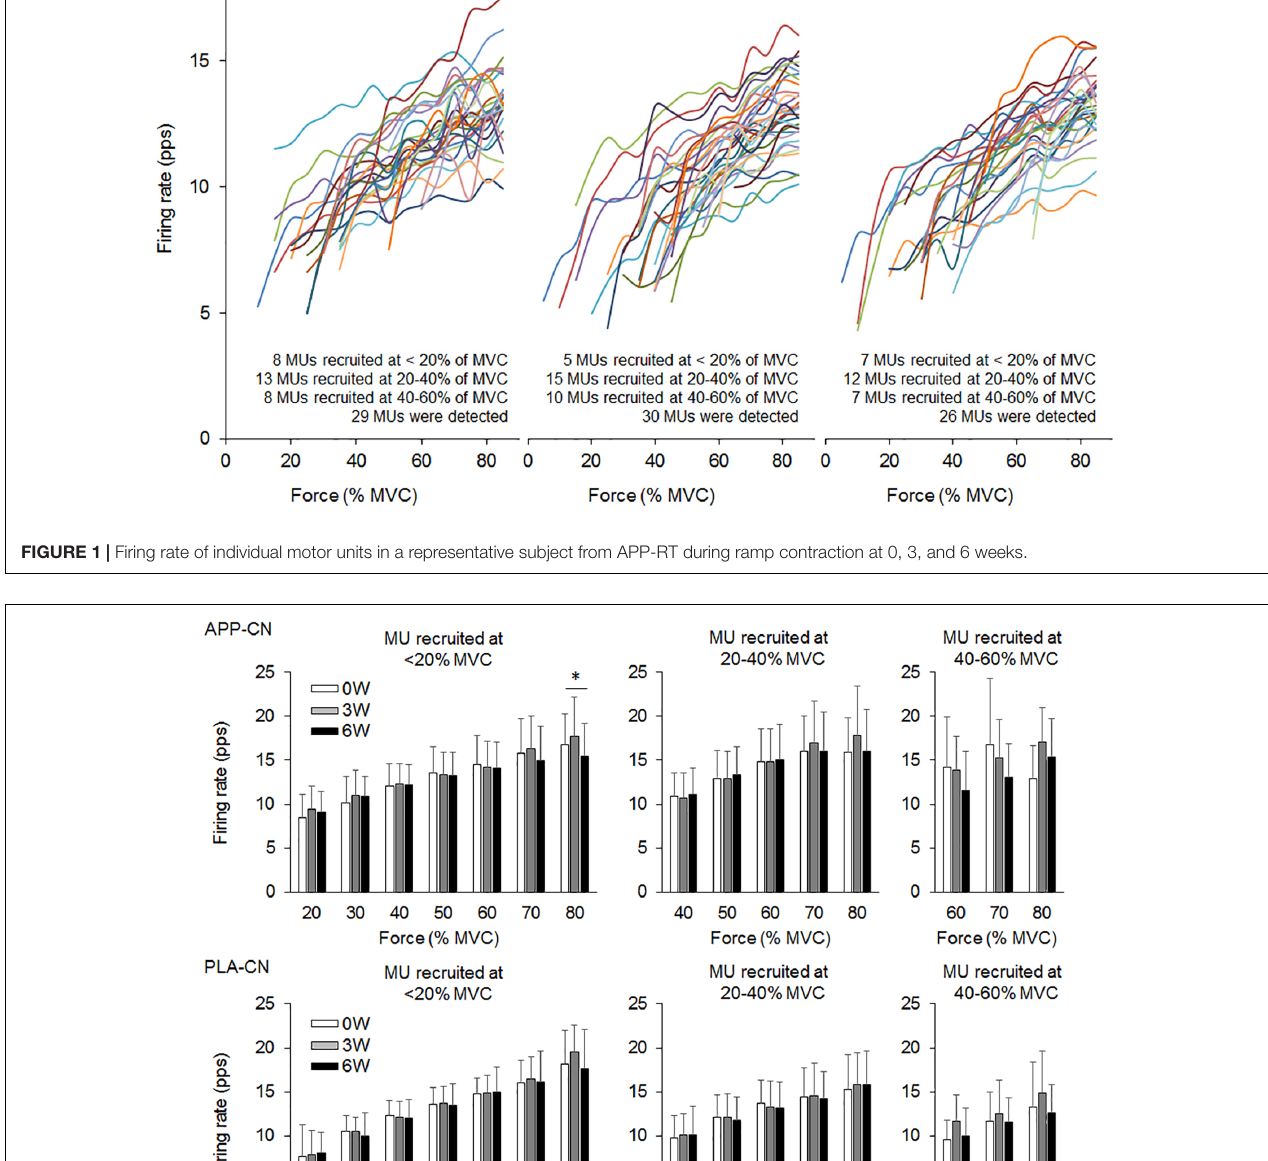
resistance training in the elderly. In young populations, Vila-Cha et al. (2010) reported an increase in the motor unit firing rate at 30% of MVC following 6 weeks of